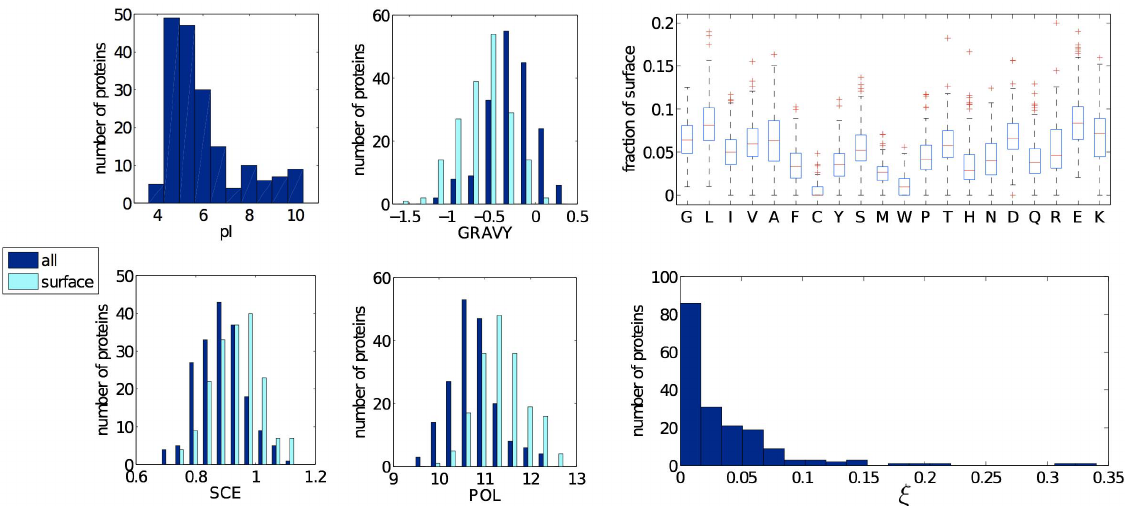
Figure 1. Summary of some of the features of the proteins contained in the NESG dataset. Histograms report the pI, average hydropathy index (GRAVY), average side chain entropy (SCE), average polarity (POL). Both the overall (blue) and the surface (cyan) valus are shown for the GRAVY index, side chain entropy (SCE) and polarity (POL). Distribution of the surface coverage for each amino acid and histogram of the crystallization propensity j are also shown.